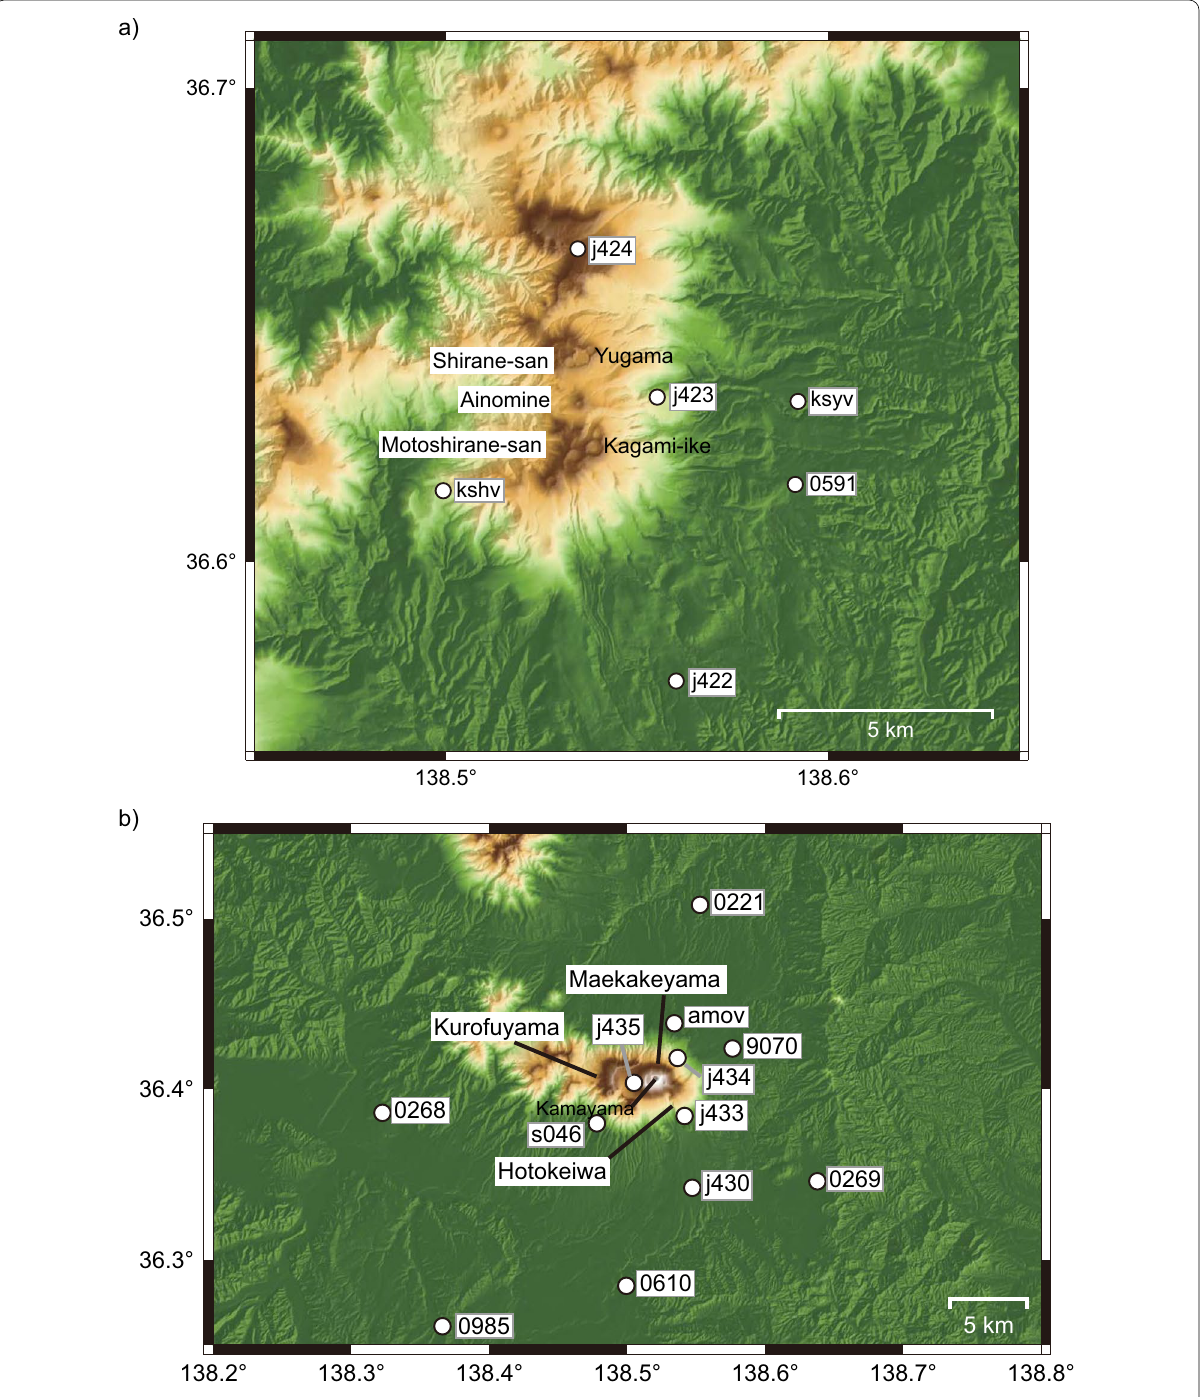
Fig. 2 Enlarged maps around Kusatsu-Shirane and Asama volcanoes. a Enlarged map around Kusatsu-Shirane volcano. Locations of three notable groups of pyroclastic cones, namely, Shirane-san, Ainomine, Motoshirane-san, are plotted. Locations of two notable craters, namely, Yugama and Kagami-ike, are also shown. White circles denote the locations of GNSS observation sites. b Enlarged map around Asama volcano. Locations of three volcanoes that consist of Asama volcano, namely, Maekakeyama, Kurofuyama, and Hotokenoiwa, are shown. The location of the Kamayama crater, which is currently the most active crater in Asama volcano, is also shown. White circles denote the locations of GNSS observation